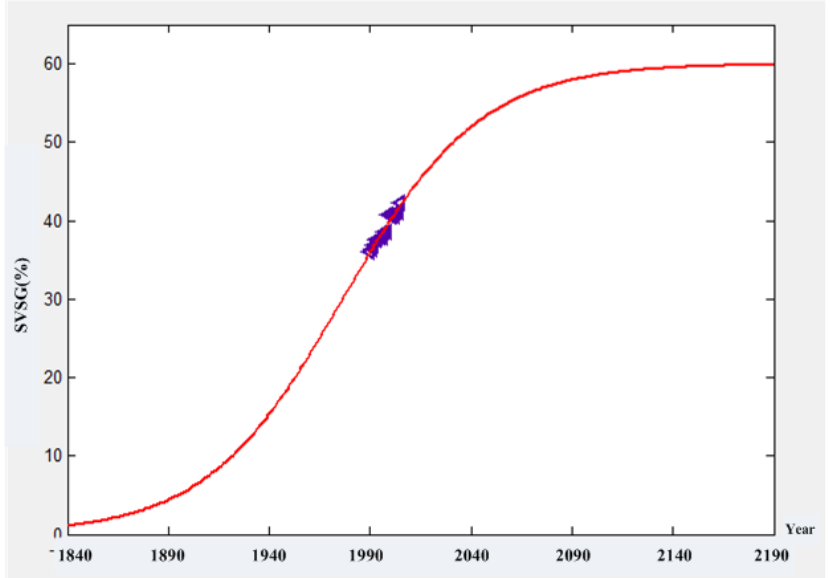
Figure 10. Fitting result of SVSG with the logistic curve model.